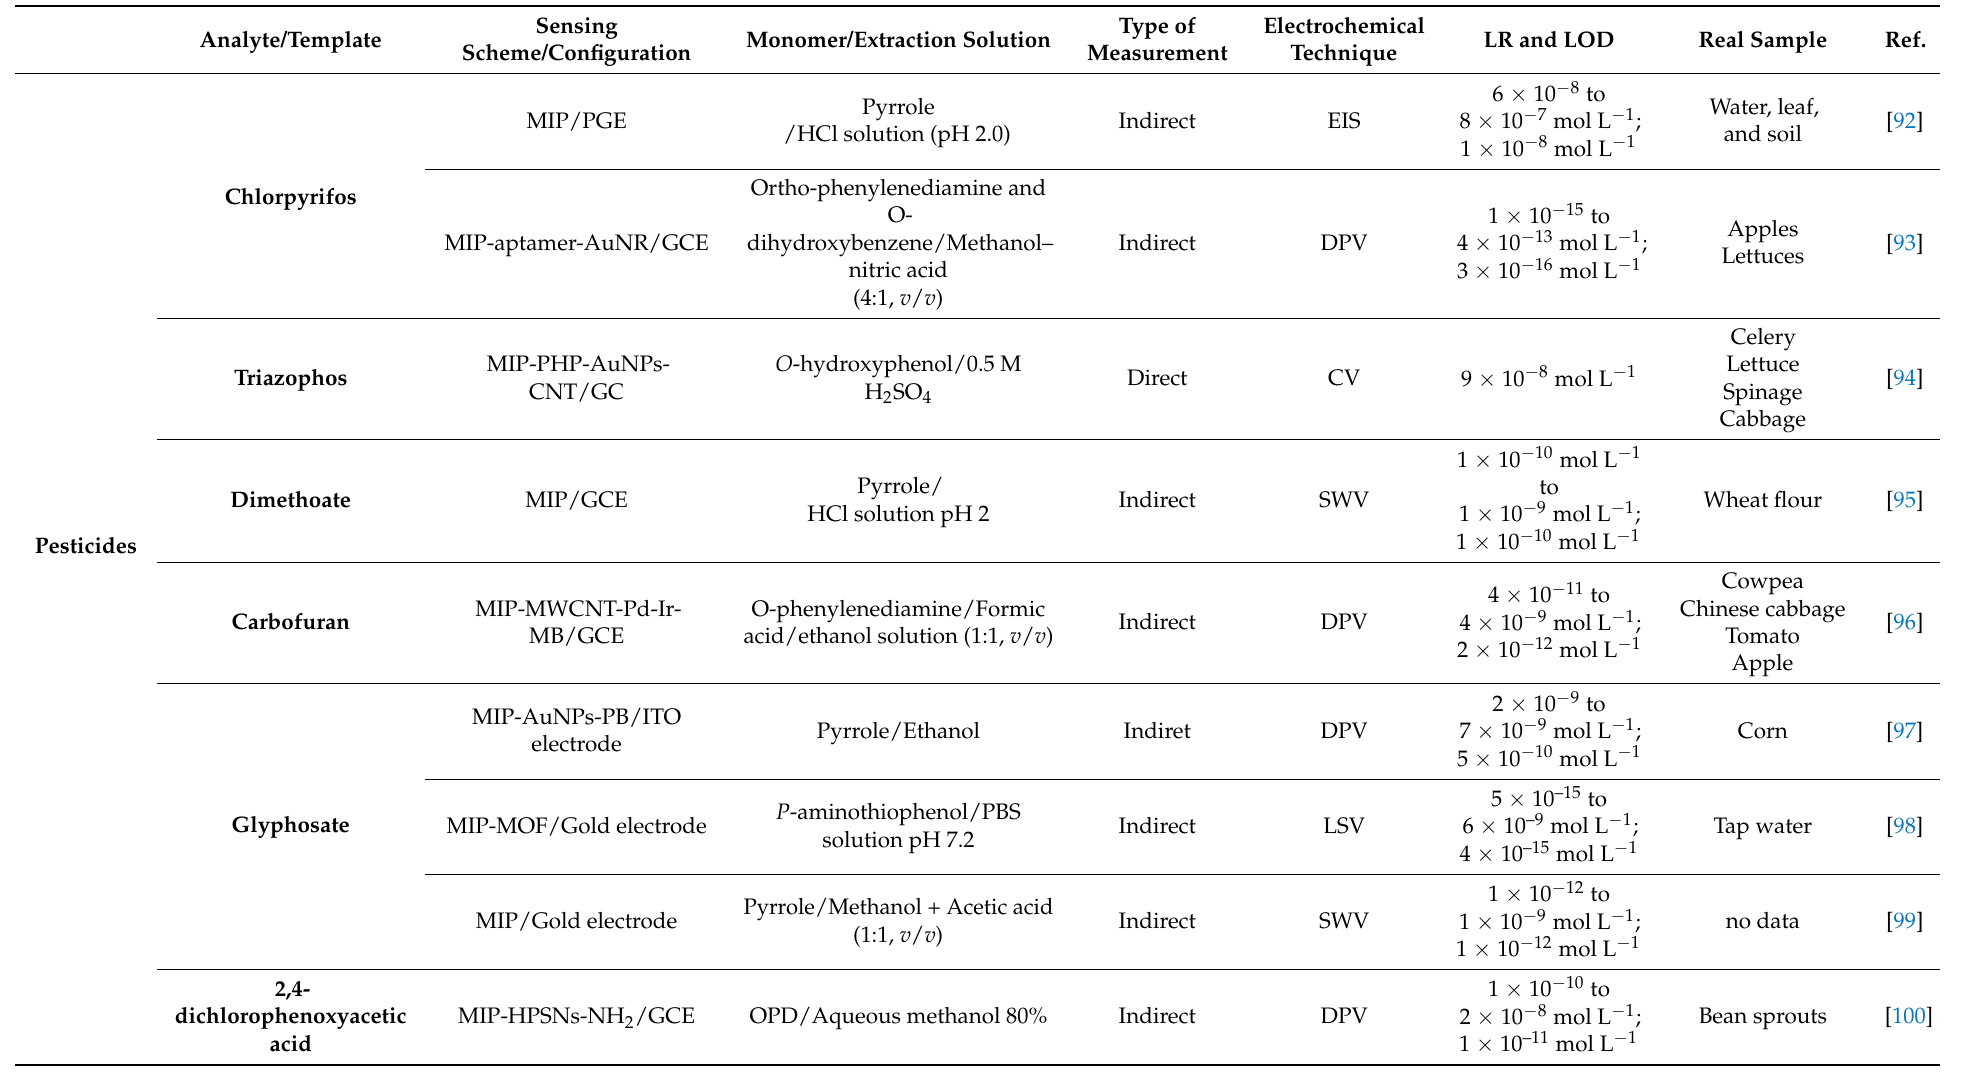
Table 2. Electrosynthesized MIP-based sensors for food